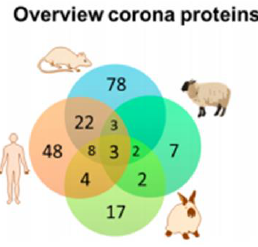
Figure 3. The similarity and diversity of the composition of the protein corona around polystyrene nanoparticles in four species are shown above, The Venn diagram indicates that few common proteins were identified among the different species studied even though identical NPs were studied in all four species. A similar diversity of corona proteins was identified when a dextran-coated magnetite NP was studied. Adapted from Muller et al. [81] with permission.